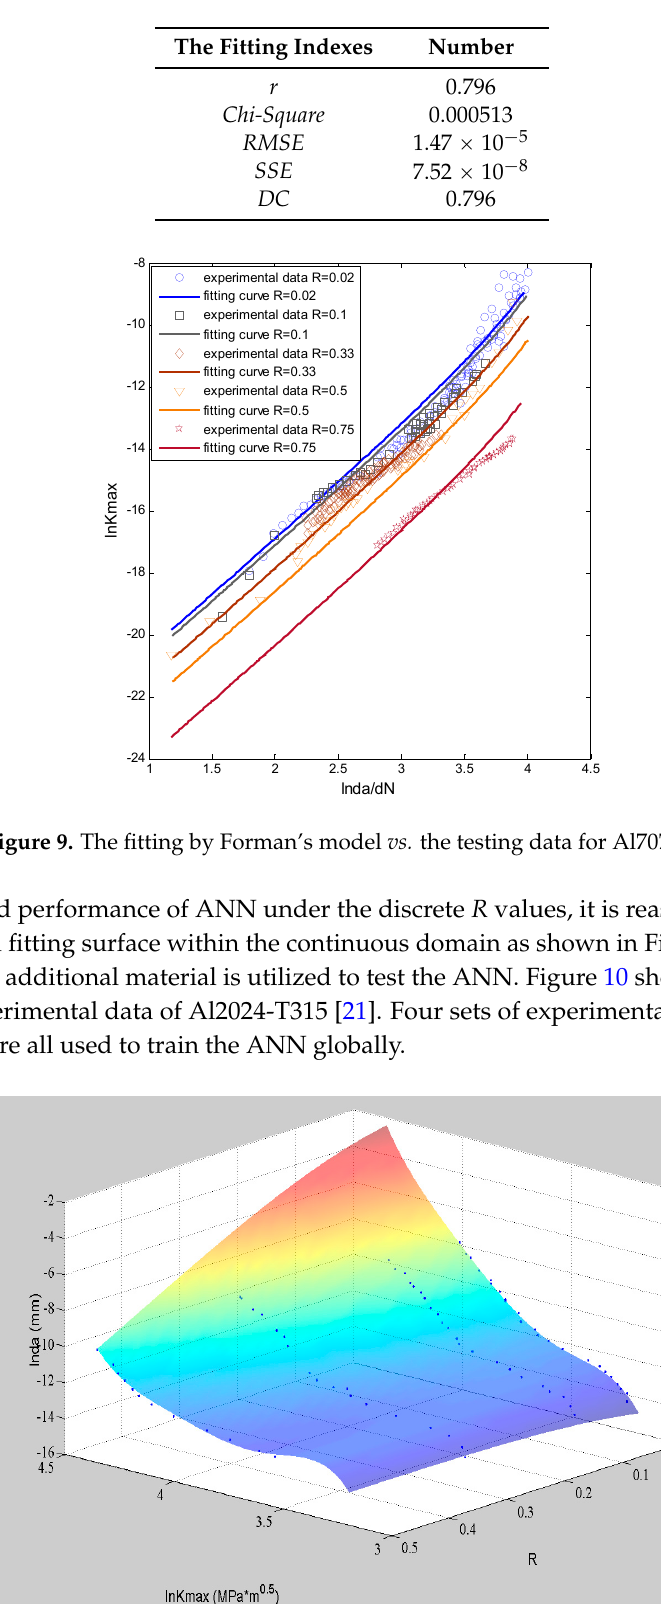
Table 2. The fitting indices of Al7075-T6.